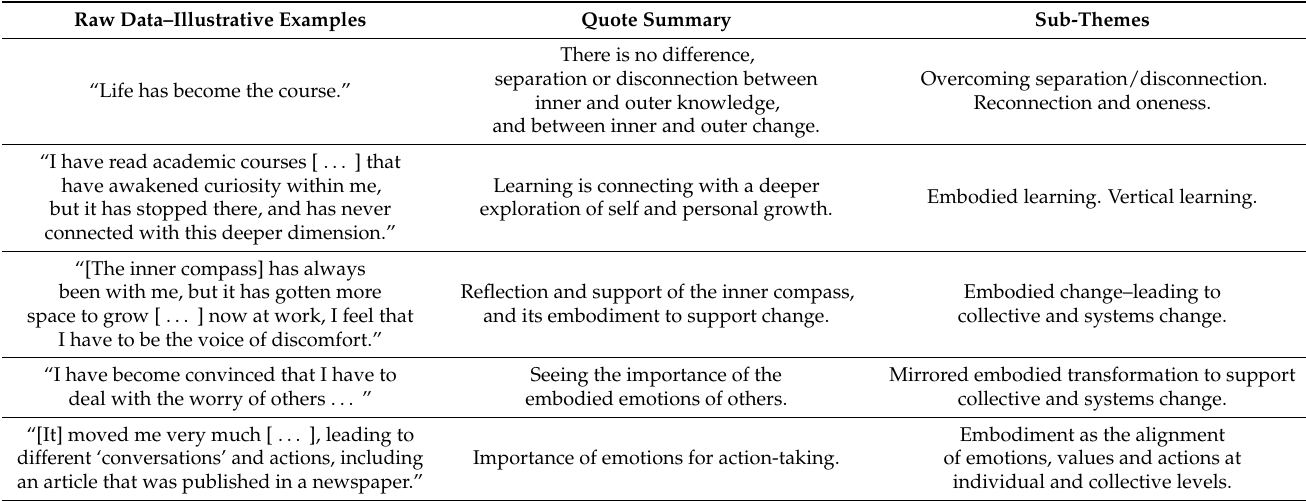
Table 4. Theme 4–Lived embodiment–lived embodied